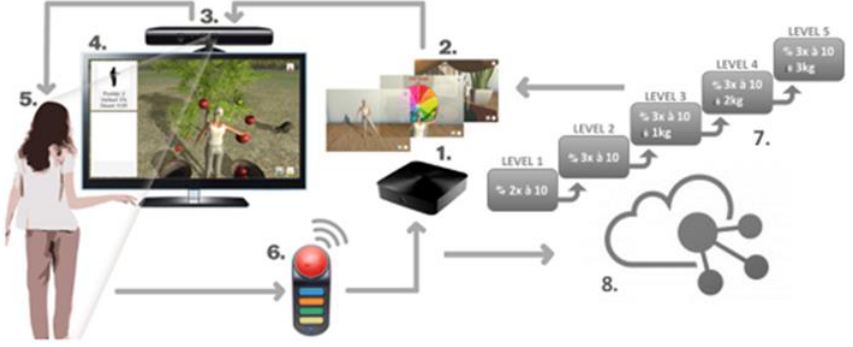
Figure 6. An overview of the MobiAssist ICT-based system and the technological components. (Permission granted by David. Unbehaun